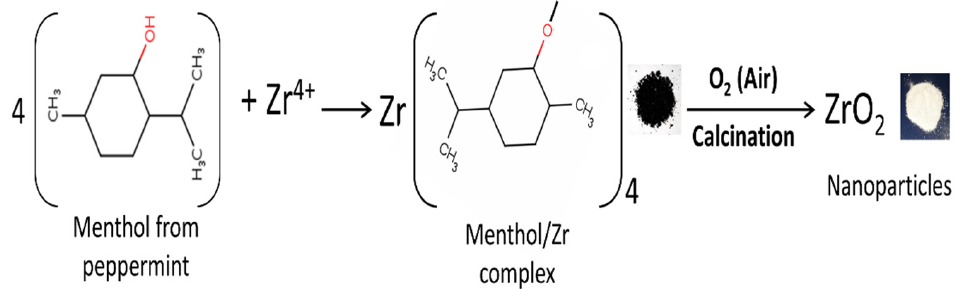
Figure 3. The nitrogen adsorption/desorption isotherms and the corresponding pore size